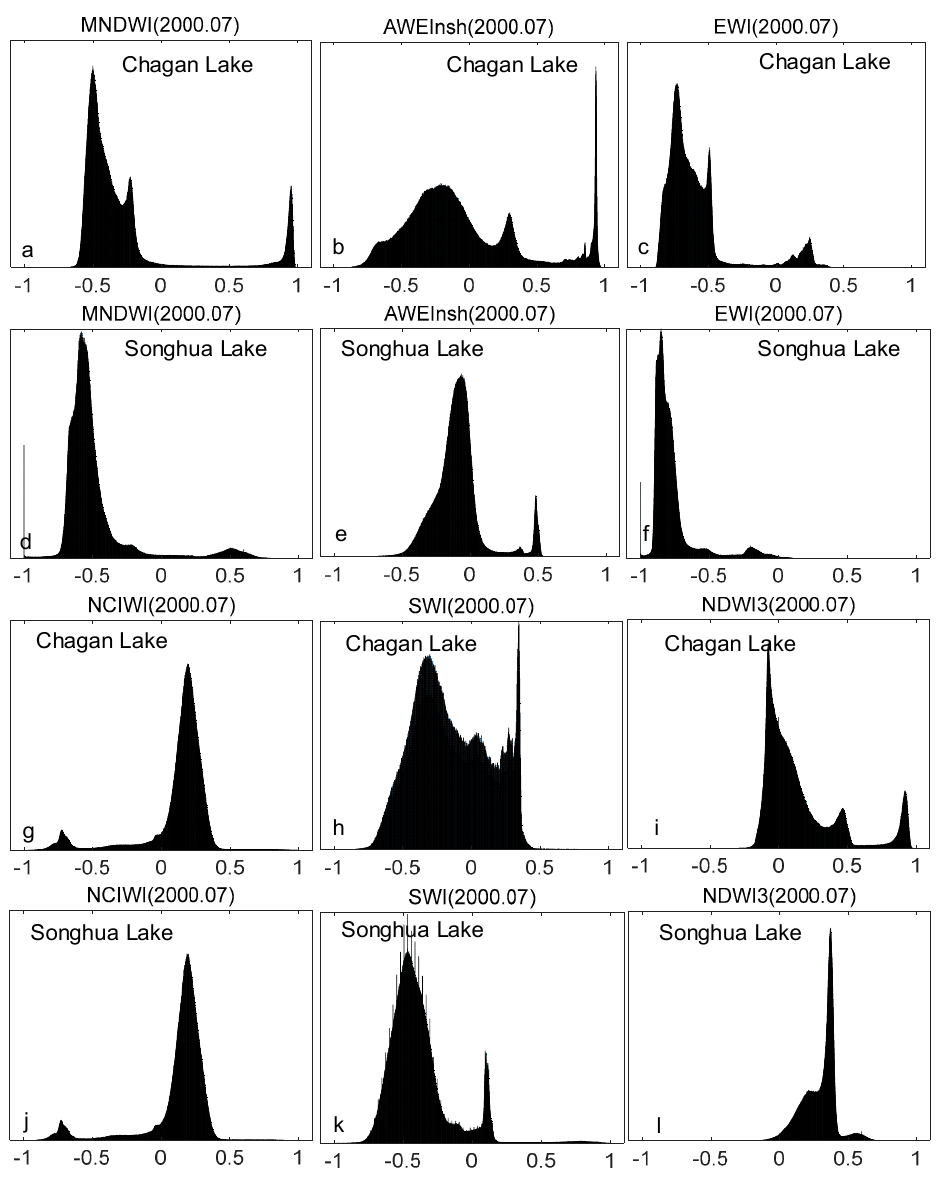
Figure 5. Gray histogram of MNDWI ( a,d ), AWEInsh ( b,e ), EWI ( c,f ), NCIWI ( g,j ), SWI ( h,k ) and NDWI3 ( i,l ) images in in July 2000 of the two study regions.